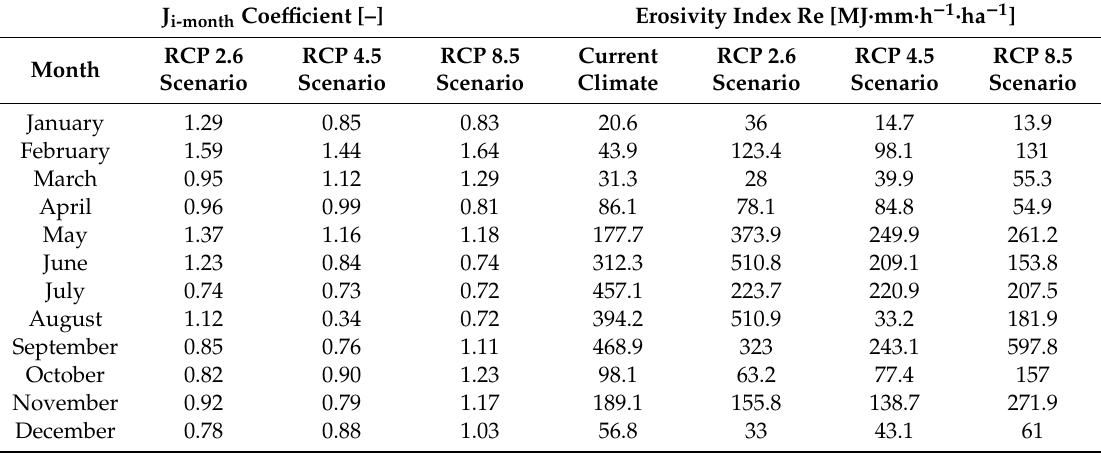
Figure 4. Precipitation results of historical and future climate simulations in the Guerna catchment. Table 3. Monthly correction factor for precipitation and erosivity index in